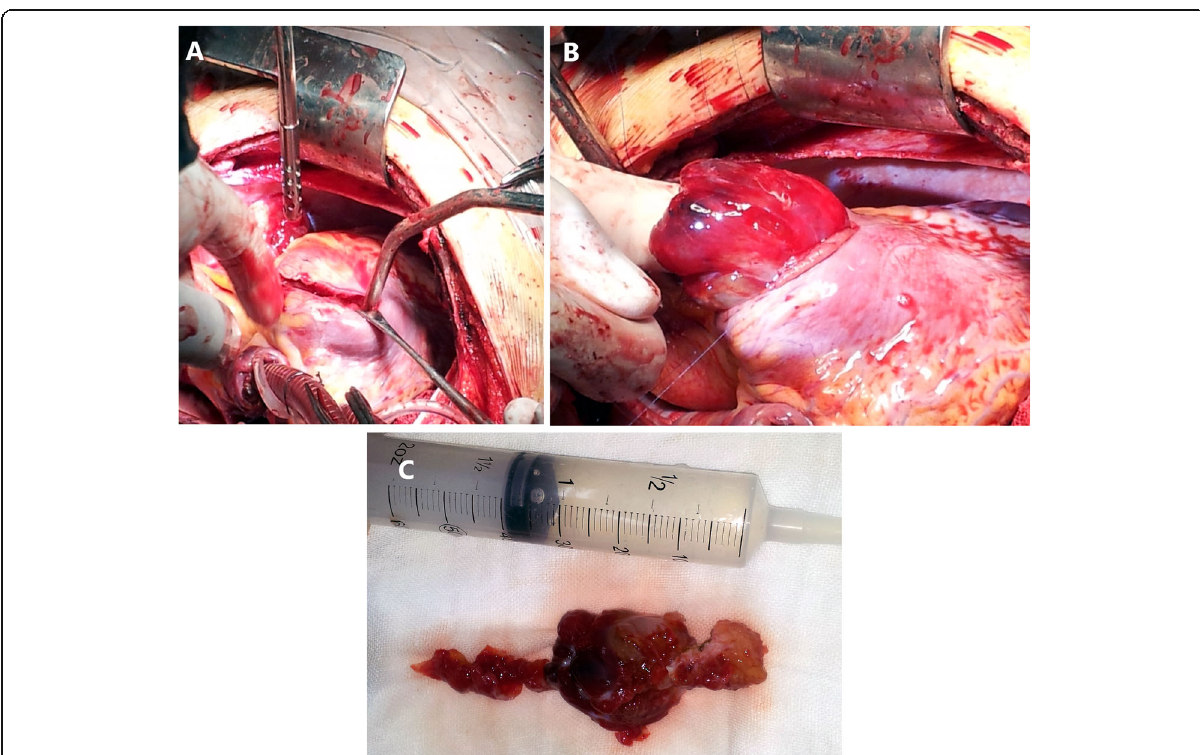
Fig. 5 Myxoma of the right ventricular outflow tract. a An 8-cm right ventriculotomy incision was at the infundibulum of the RVOT 2 cm lateral to the left anterior descending coronary artery. b The mass is shown out of the right ventriculotomy incision with its basal attachment to the IVS. c The specimen after excision from the